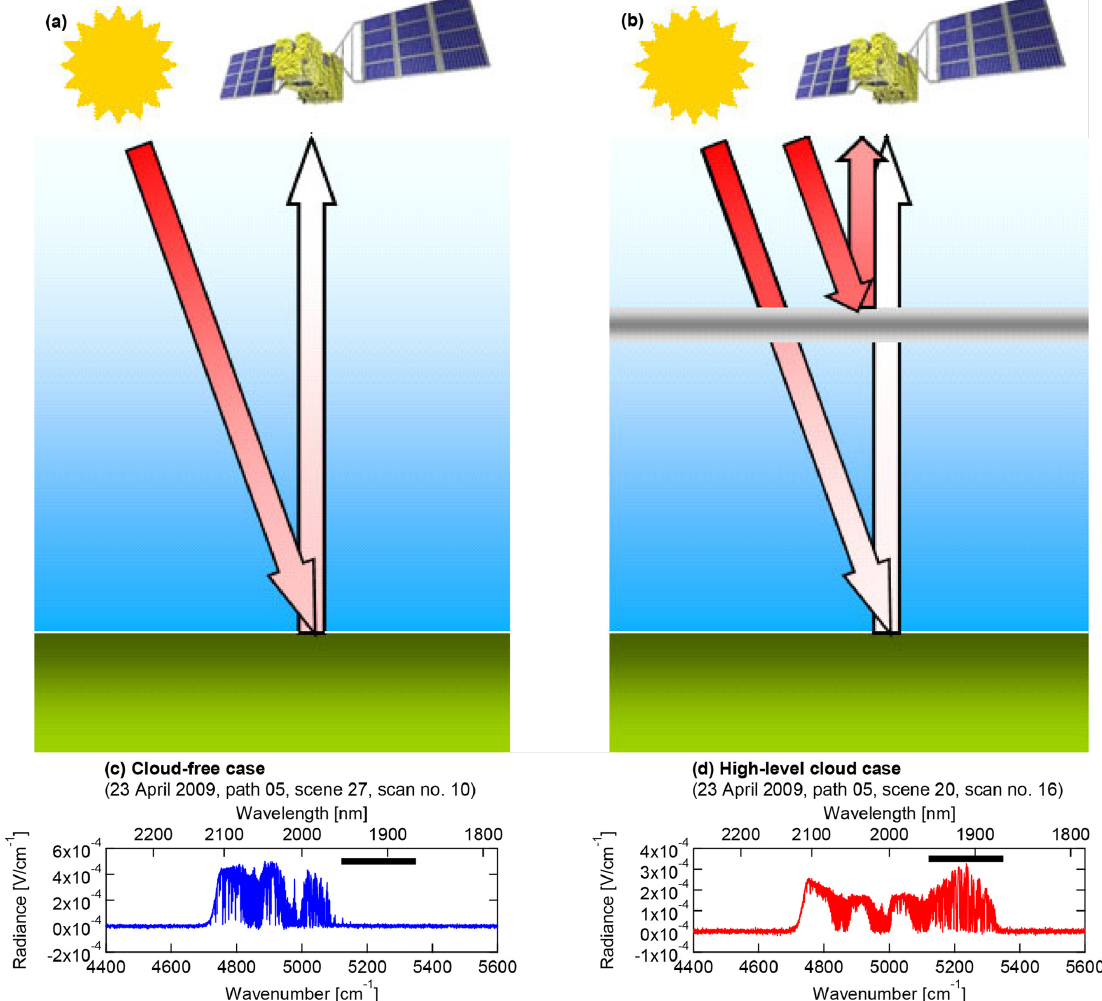
Figure 1. Panels (a, b) show schematics of the radiative transfer effects without (left) and with (right) scattering particles in the upper troposphere. The panels (c) and (d) show examples of the spectral shape of Band 3P without and with the scattering particles. The thick black line indicates the location of the water vapor absorption band focused in this